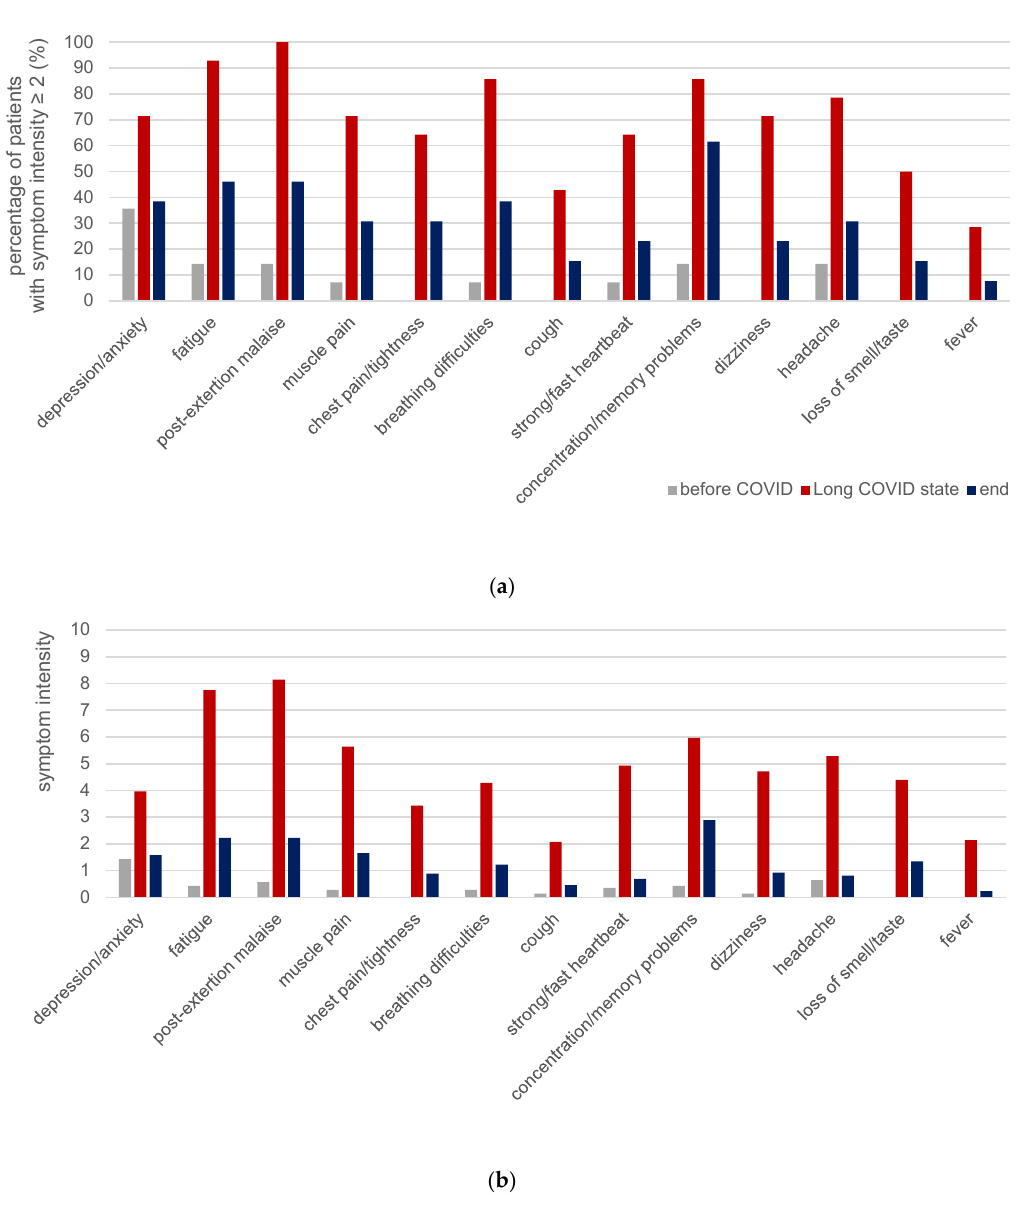
Figure 6. Symptom intensity. ( a ) Percentage of patients who rated the symptom intensity with ≥ 2. ( b ) Arithmetic means of the symptom intensity on the scale from 0 (no) to 10 (very strong). Both are given for each symptom and time point: before COVID (grey, n = 14), during long COVID state (red, n = 14, corresponds to pre measurements), and end (blue, n = 13, corresponds to end measurements). Absolute symptom intensities are displayed in Table 3 and Figure 6b. The Friedman test was significant for each symptom. From ‘before COVID’ to ‘long COVID state’, the intensities increased significantly for each symptom ( p < 0.001 to 0.024), except for fever ( p = 0.202). In long COVID state, all patients reported to suffer from fatigue, post-exertion malaise and breathing difficulties with an intensity of at least 1. Most prominent were post-exertion-malaise and fatigue with an intensity of 8.1 and 7.8, respectively. The other symptoms did not occur in each patient, whereby fever was the rarest (four patients).